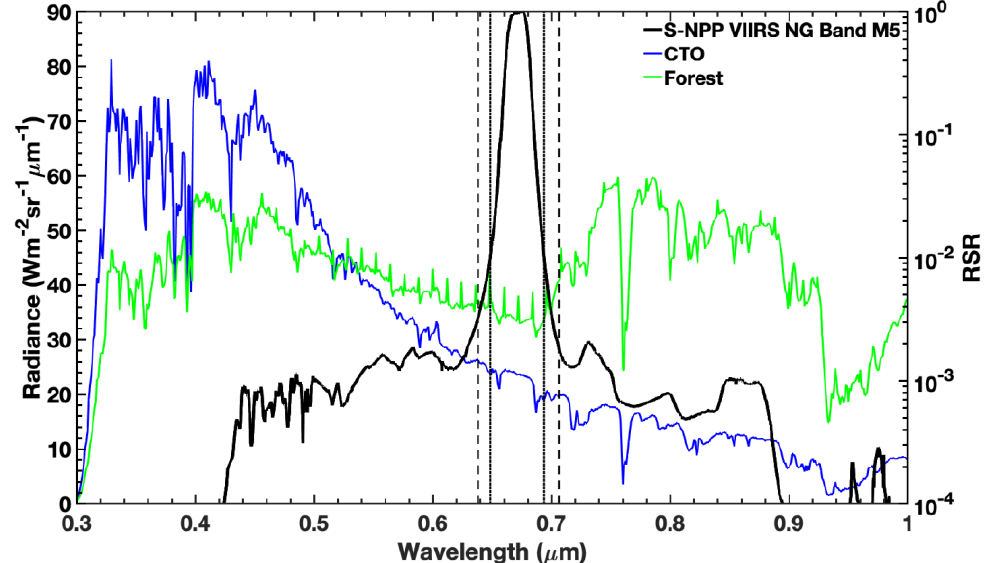
Figure 5. Same as Figure 4, except with an S-NPP VIIRS NG band M5 example.